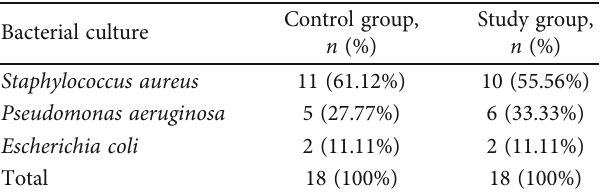
Table 2: Prevalent pathogens isolated from diabetic wound at